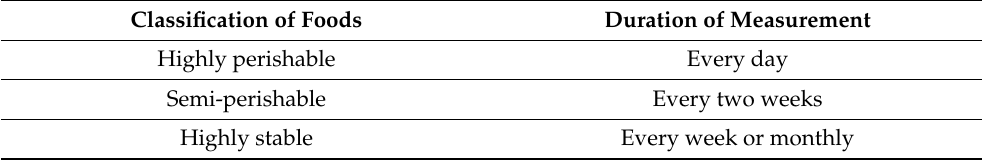
Table 4. Duration of evaluation of shelf life.